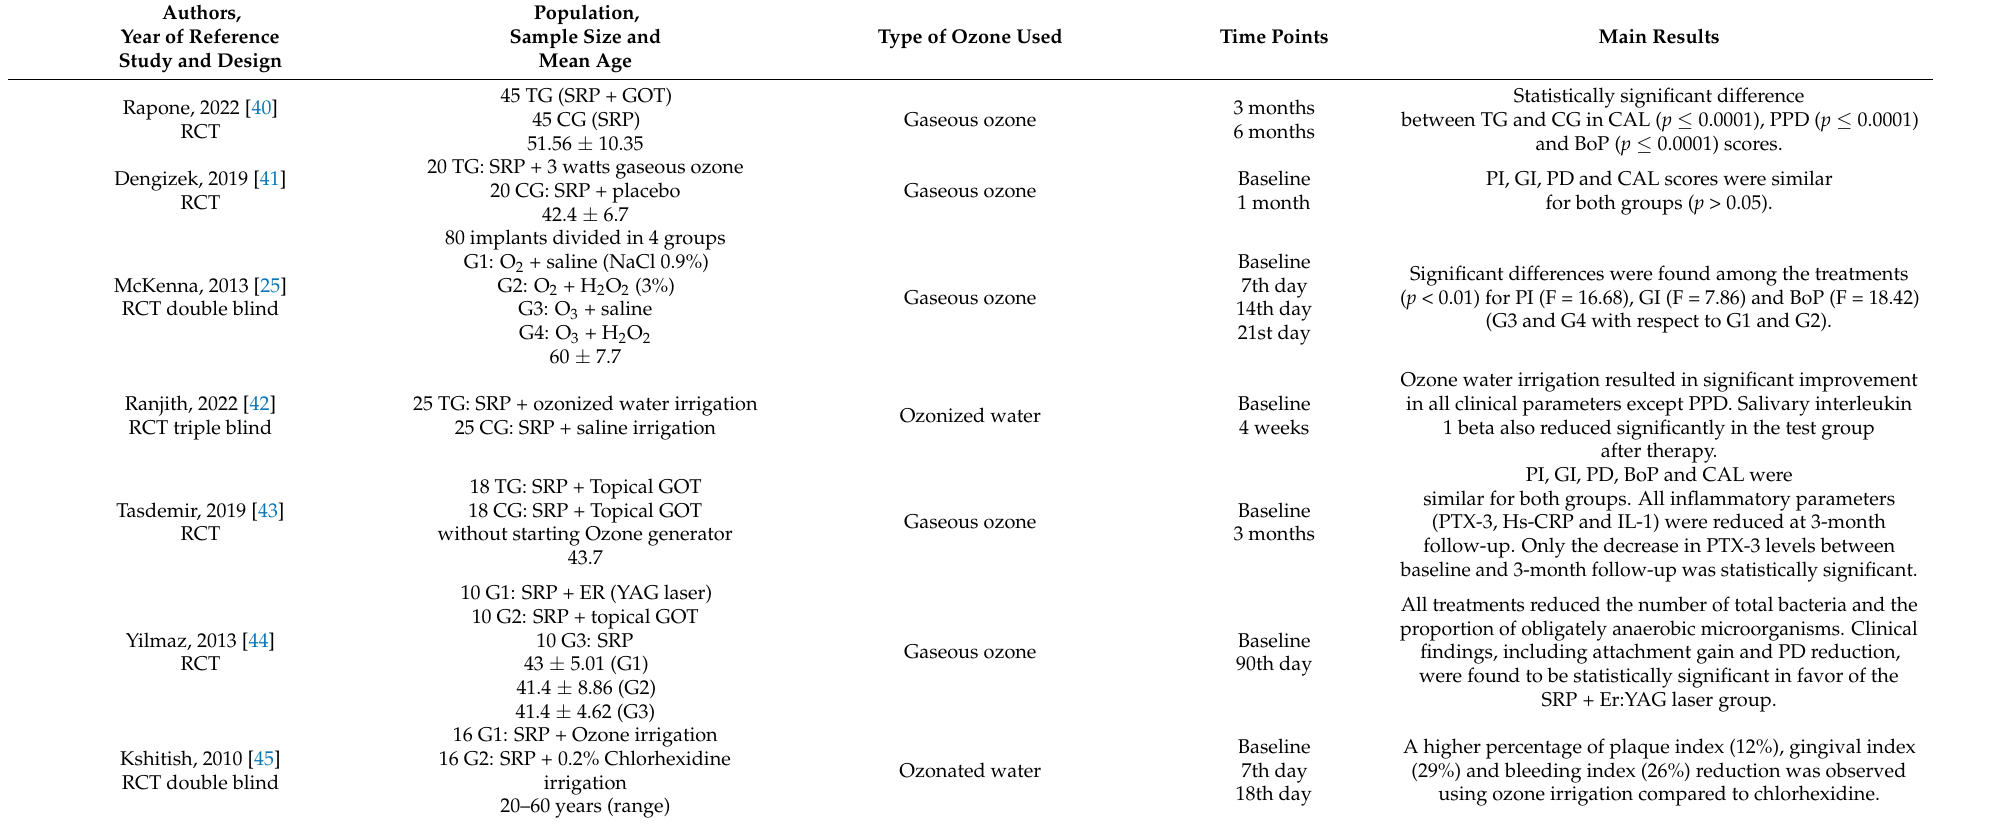
Table 2. Characteristics of the studies included in the present systematic review: author(s) and year of publication; study design; population, sample size, mean age; type of ozone used; Main results and Conclusions. Periodontal and peri-implant clinical, radiographic and crevicular parameters, including clinical attachment loss (CAL), probing depth (PPD), bleeding on probing (BoP), plaque index (PI), gingival index (GI), marginal bone levels (MBL), cytokine profile including interlukine-1b (IL-1b); matrix metalloproteinase (MMP-8) and periodontal treatment with scaling and Root Planing (SRP); Full-Mouth mechanical debridement (FMMD) and Test Group (TG); Control Group (CG); Gaseous Ozone Therapy (GOT); Right Quadrants (RQ); Left Quadrants (LQ); mechanical debridement